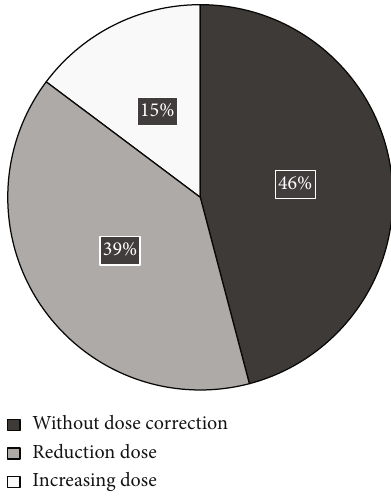
Figure 5: Therapeutic decision based on 6-TG concentrations. 6- TGN: